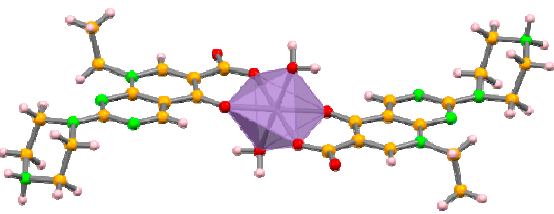
Figure 3. Crystal structure of complex I , depicting the distorted octahedral geometry of the metal centre, similar to complexes II and III .